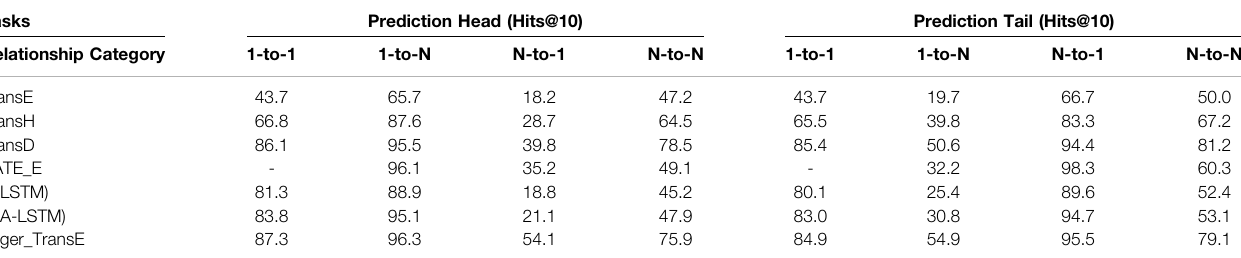
TABLE 4 | Results on FB15K by the category of relationships. Tasks